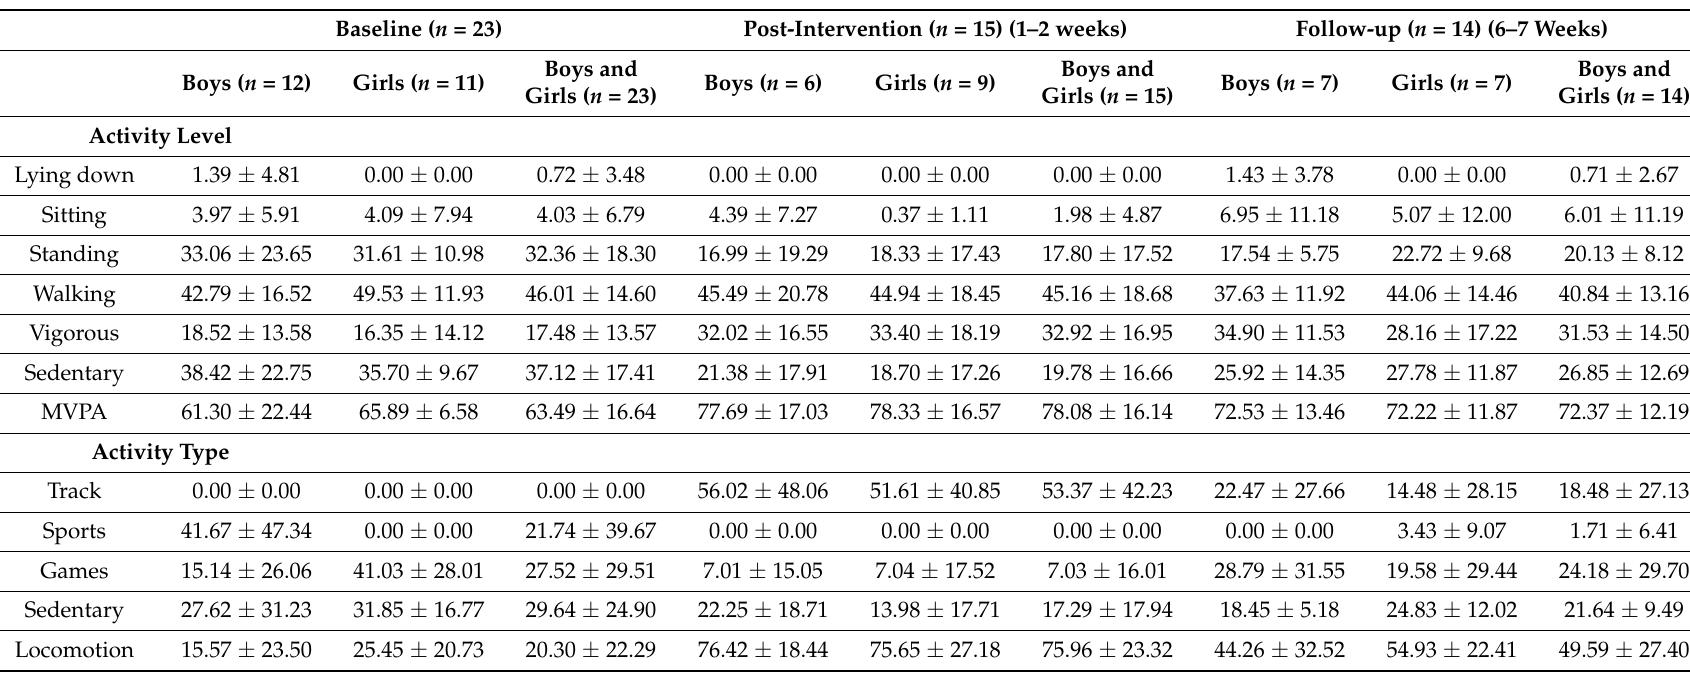
Table 3. Changes in Y3 and Y4 mean ( M ± SD ) percentage (%) of morning break times spent in the SOCARP activity variables of: ‘activity level’ and ‘activity type’ at baseline, post-intervention, and follow-up data collection